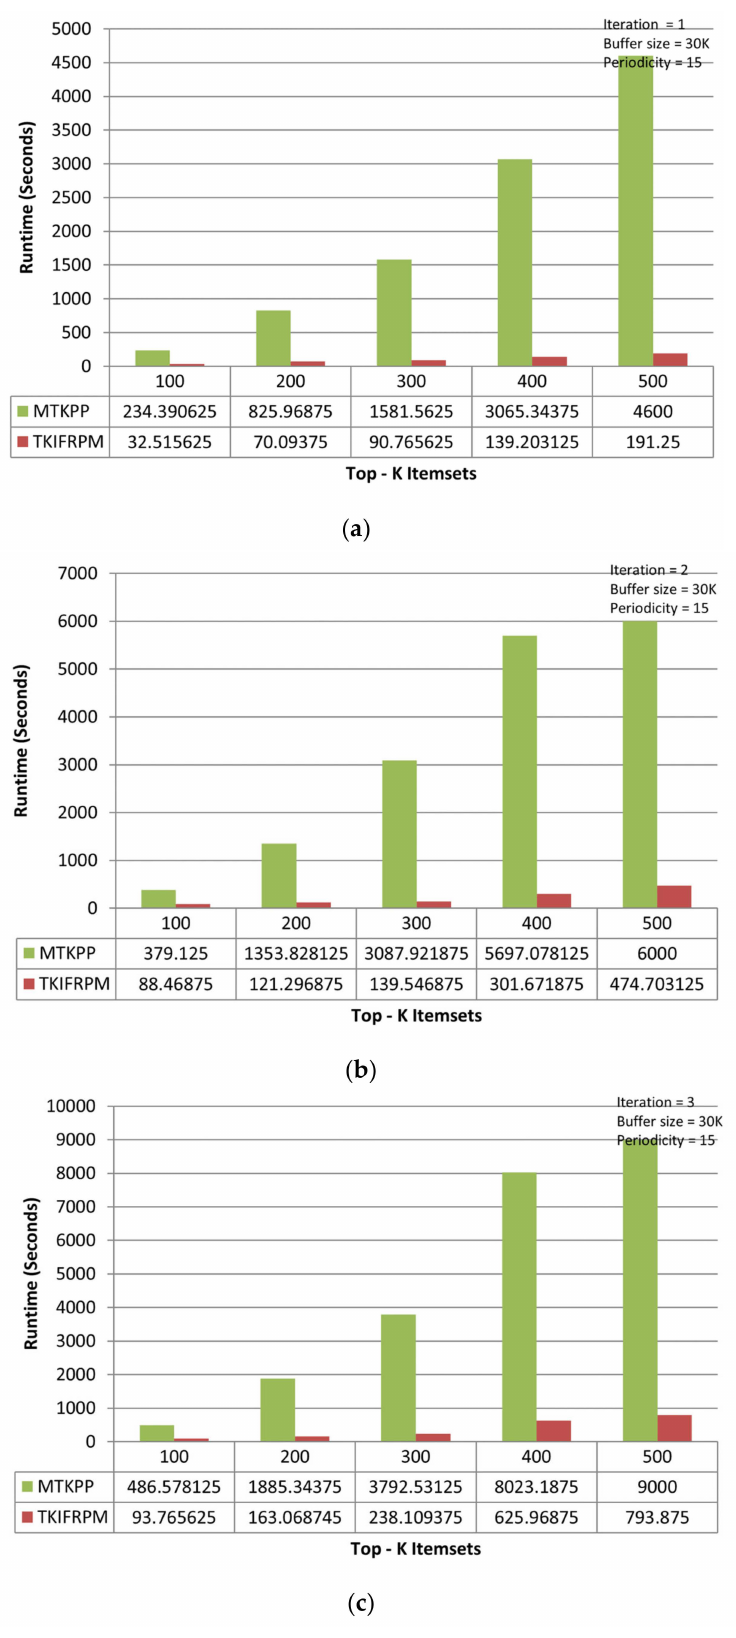
Figure 4. ( a ) Performance trends of the first iteration on the accident dataset. ( b ) Performance trends of the second iteration on the accident dataset. ( c ) Performance trends of the third iteration on the accident